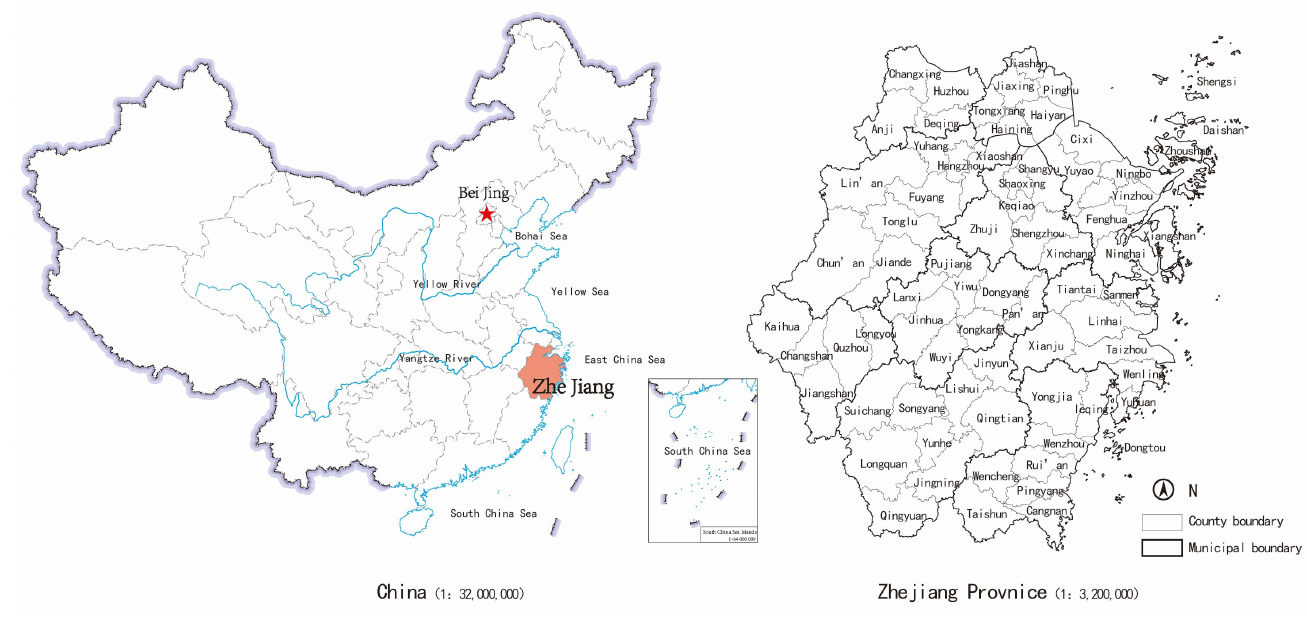
Figure 1. Location of Zhejiang Province in China.